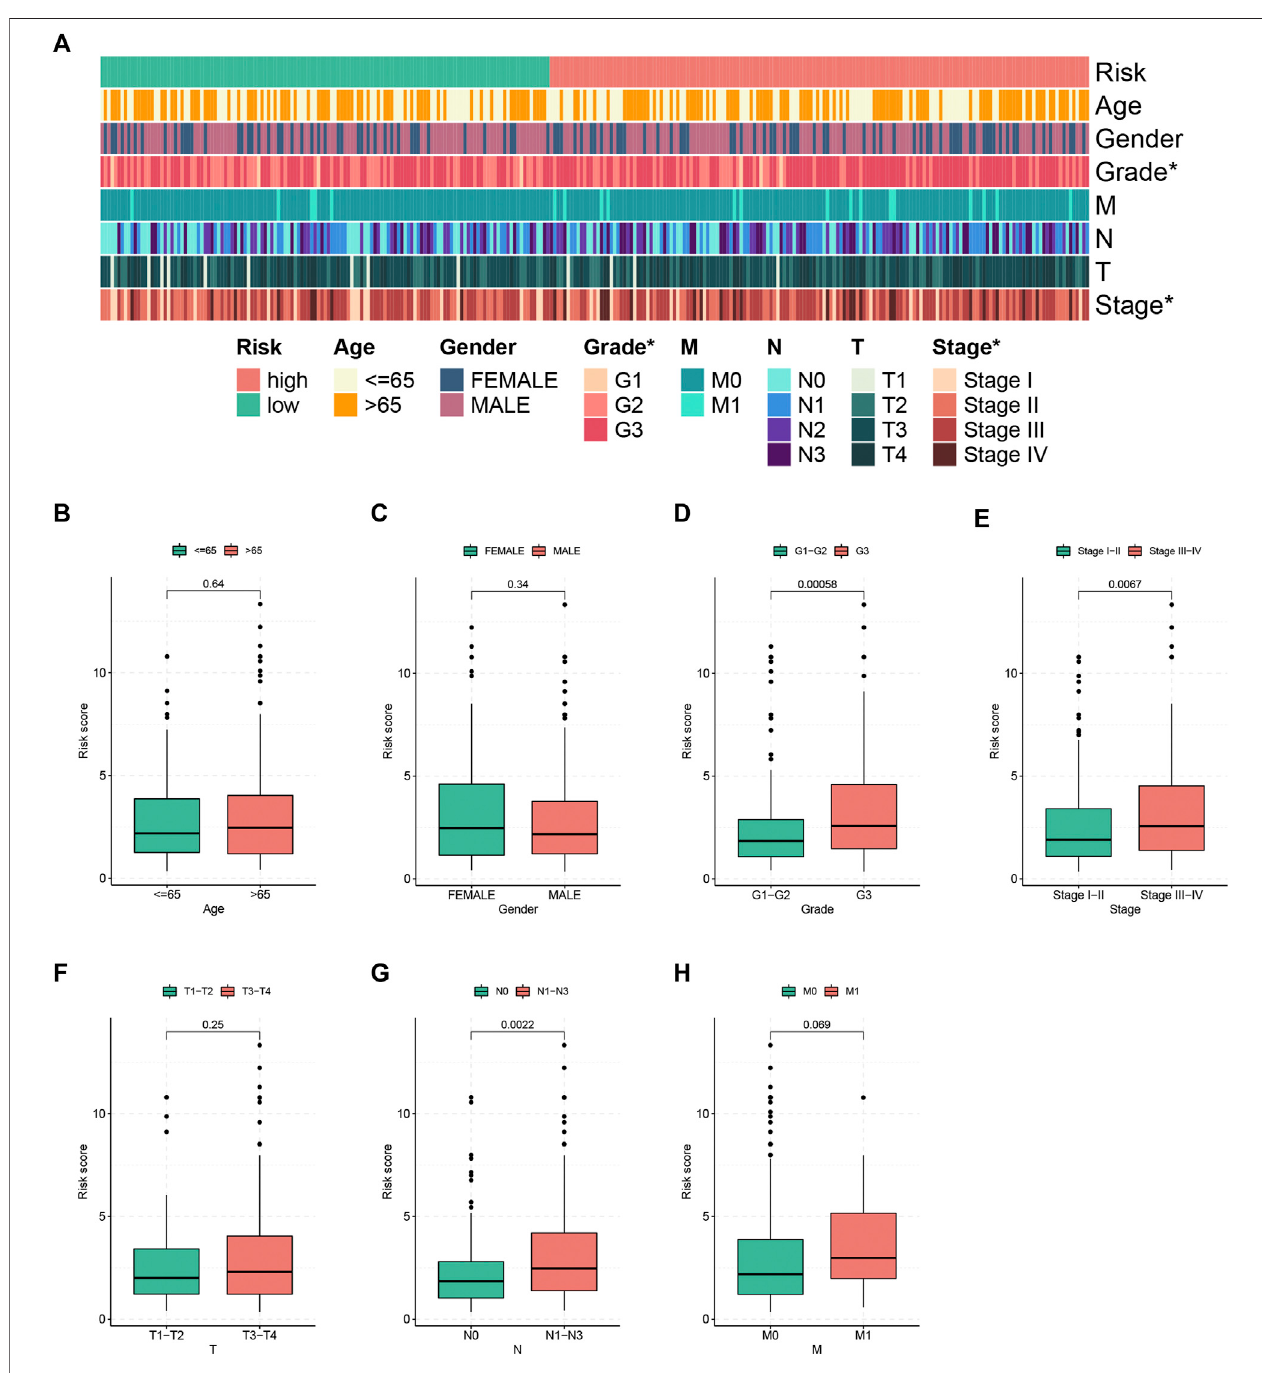
FIGURE 4 | Clinical correlation of the FRLP risk score model. (A) Heatmap showing the clinical relevance of the risk score model (* p < 0.05). (B – H) Boxplots showing risk score differences in different age, gender, tumor grade, tumor stage, T status, N status, and M status groups.